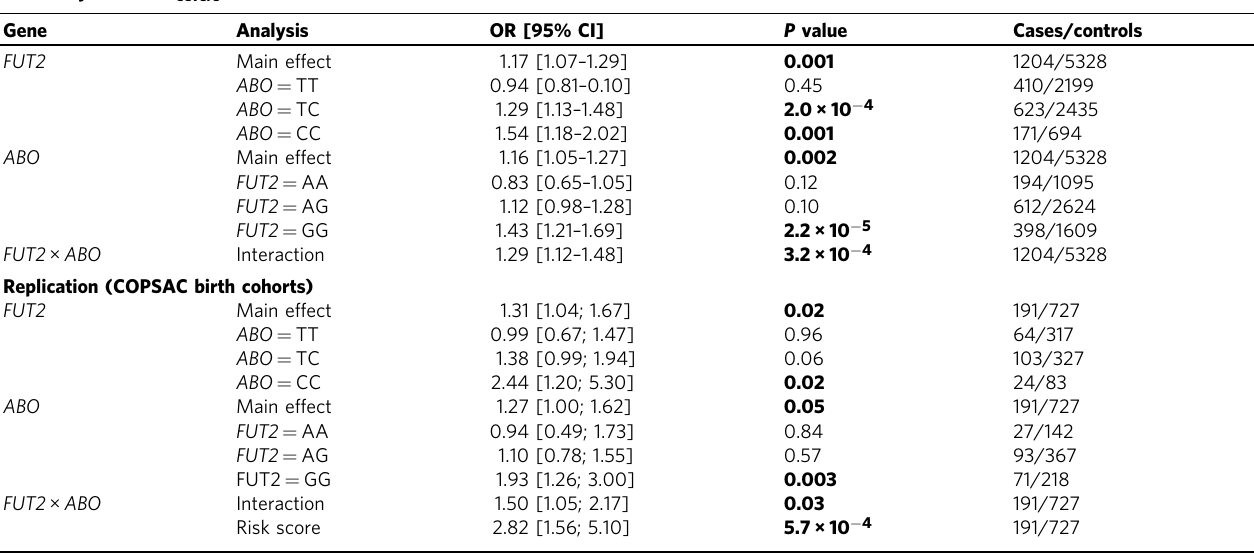
Table 3 FUT2 (rs601338) and ABO (rs505922) main and strati fi ed effects in the COPSAC severe study (discovery), and the COPSAC birth cohorts (replication).